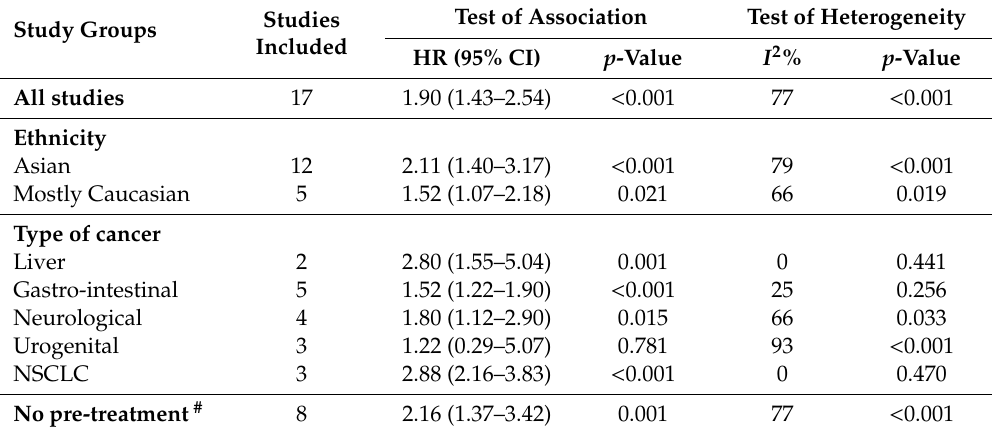
Figure 3. Forest ( A ) and Funnel ( B ) plots for the e ff ect of miR-222 overexpression on overall survival. ES, e ff ect size (i.e., hazard ratio); W, weight; Sig, statistical significance; N, total number of cancer patients included in the survival analysis. Table 5. Summary of random e ff ect meta-analyses for the association between miR-222 overexpression and OS in cancer patients.